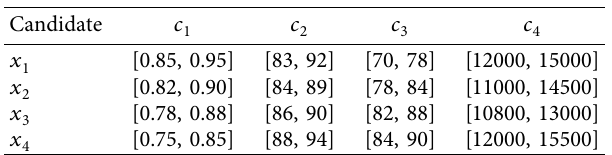
Table 4: Interview scores.